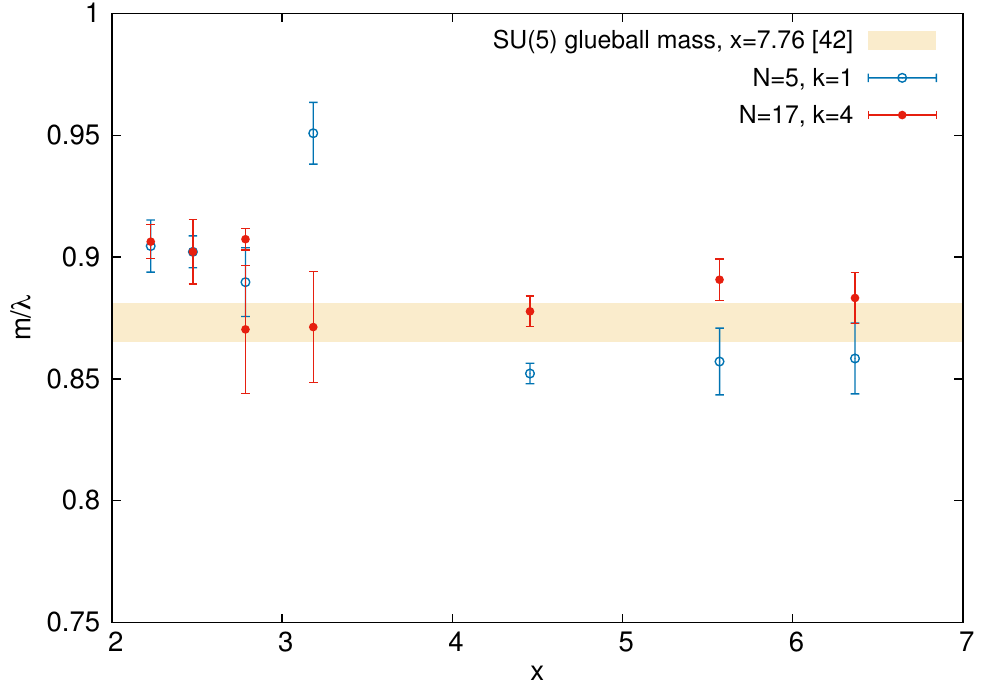
Figure 9. Comparison between the x dependence of the masses of the glueball states in f N; k g = f 5 ; 1 g and f 17 ; 4 g